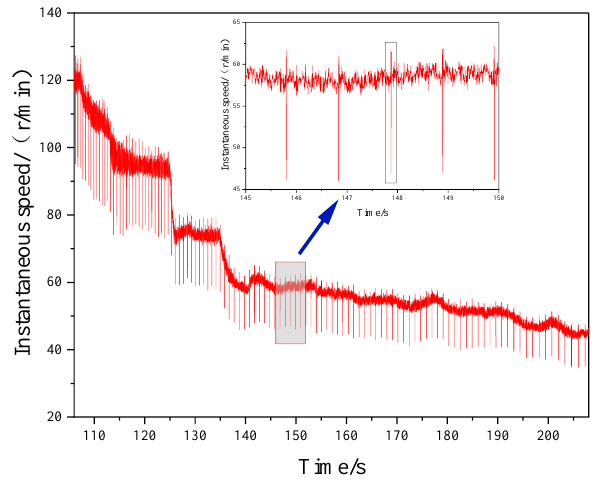
Figure 7. Shafting instantaneous speed partial enlarged plot.